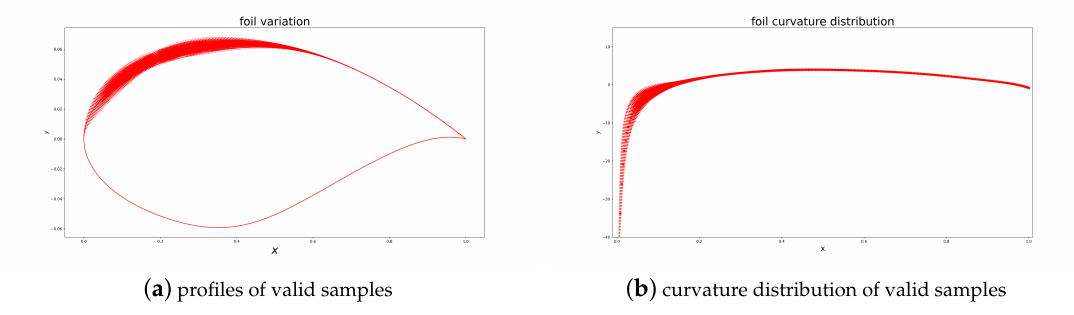
Figure 6. Illustration of valid airfoil samples in form of x-y profiles as well as their corresponding curvature distribution along